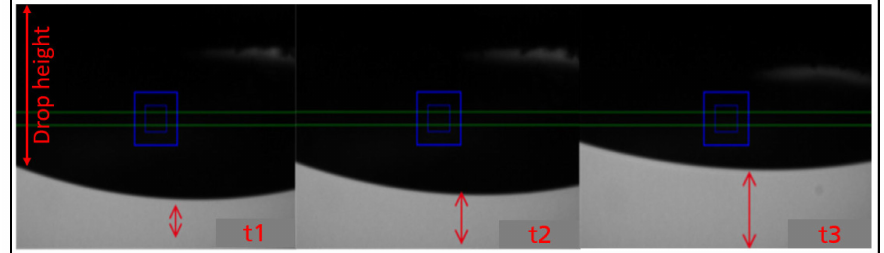
Figure 10. Coalesced drop of B-ink (2) retracts back into the nozzle, even after being subjected to 60 V and 5 s purging, failing droplet